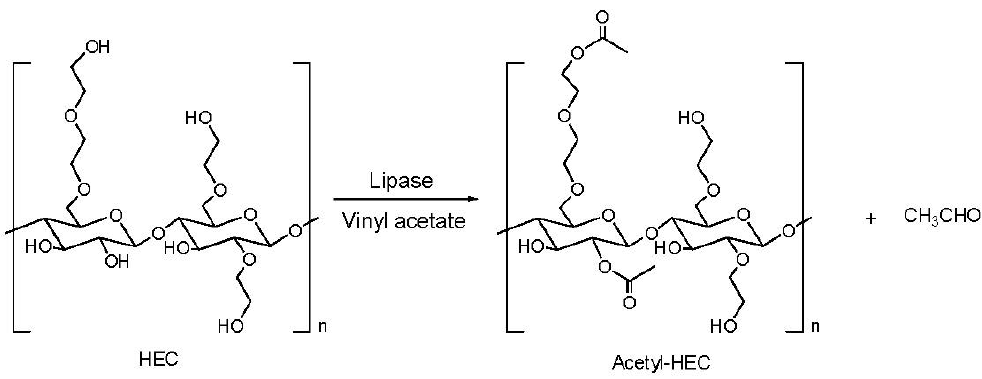
Figure 1. Lipase-catalyzed synthesis of acetylated hydroxyethylcellulose (HEC).